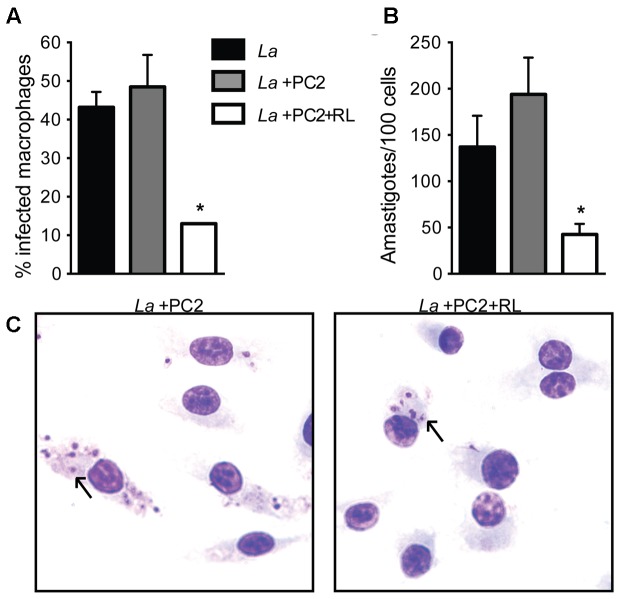
Reduced uptake of PC2-sensitized and photo-inactivated L. amazonensis by primary macrophages. Bone marrow-derived macrophages were infected with L. amazonensis (La) (black bar) or PC2-sensitized parasites with (white bar) and without (gray bar) exposure to red light (RL) at a host-parasite ratio of 1:10 for 4 h. Cells were processed for microscopy to assess: (A) the percentage of infected macrophages; and (B) the number of Leishmania per 100 macrophages. (C) Representative photomicrographs of (A,B). Data are presented as mean ± SD from a representative experiment performed in quadruplicate (Kruskal–Wallis test, ∗p < 0.05). Arrow, endocytosed Leishmania.